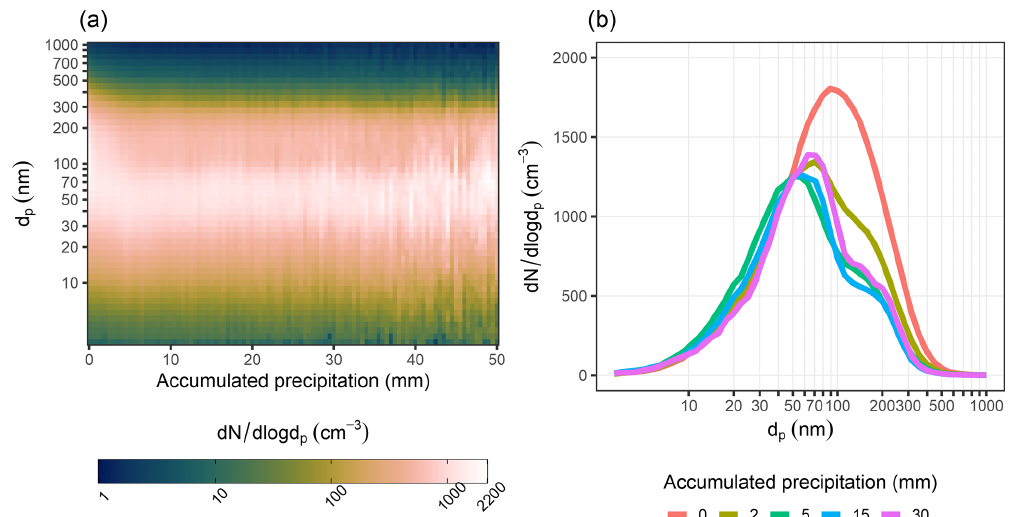
Figure 3. The aerosol size distribution ( d p = 3–1000nm) as a function of the 0–50mm of accumulated precipitation along 96h air mass trajectories is shown in panel (a) . Data are shown as medians for binned accumulated precipitation (bin size 0.5mm). Median size distribu- tions are presented for selected values of accumulated precipitation in panel (b) . The figure includes DMPS data between January 2005 and August